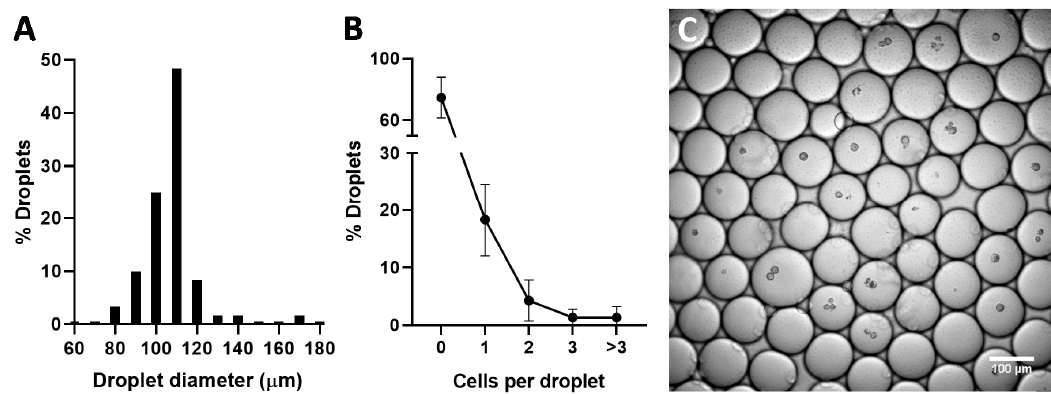
Figure 6. Histogram of microdroplet diameter ( A ); number of A549 cells encapsulated per microdroplet ( n > 600) ( B ); example confocal microscopy image of obtained cell-containing microdroplets ( C ).